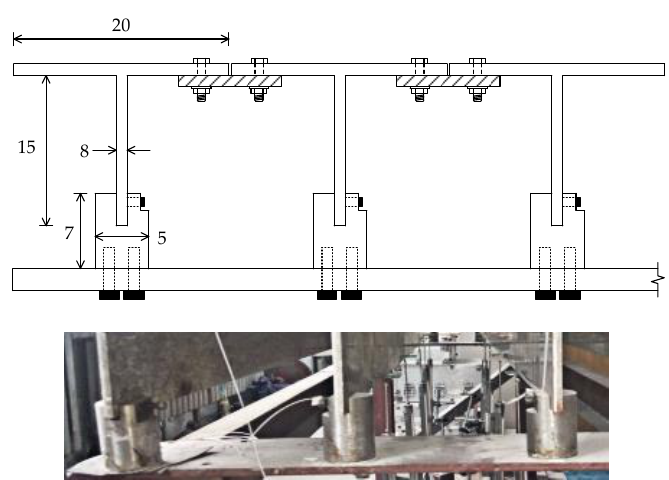
Figure 14. Photo of the entire experimental system of the model bridge.